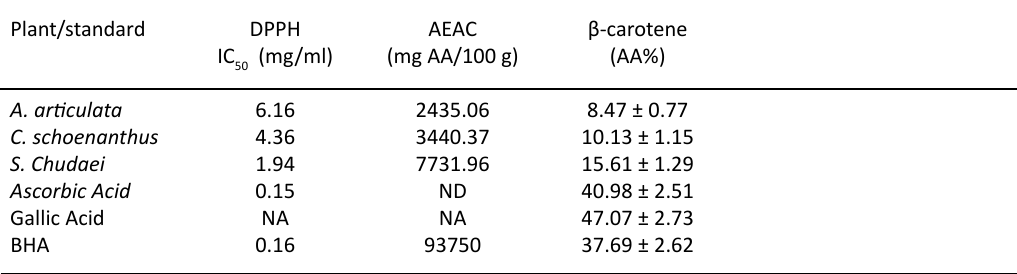
Table 6. Scavenging power of plant extracts Plant/standard